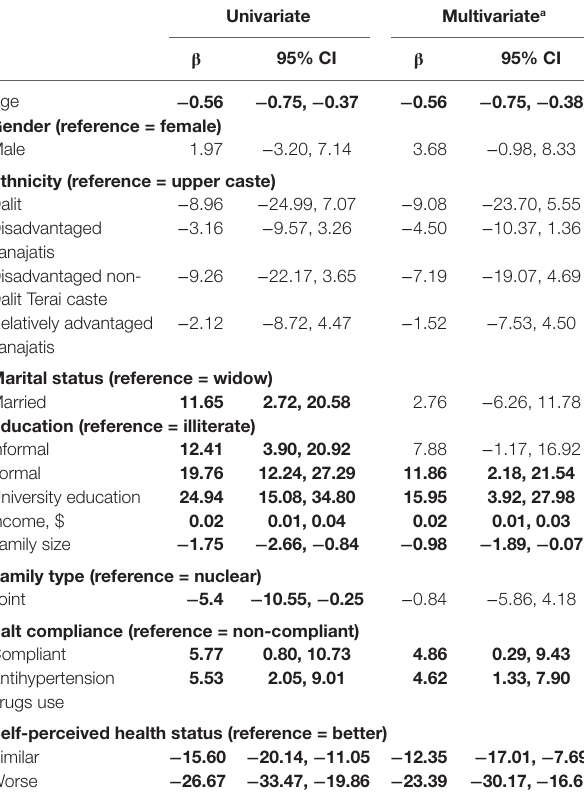
Table 1 | Descriptive characteristics of the study participants ( n = 180).